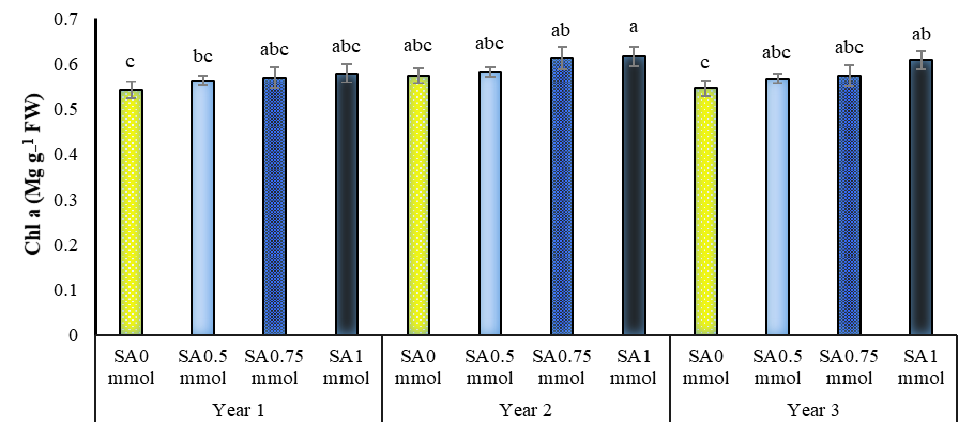
Figure 4. Dual interaction of experimental years (2016 – 2017, 2017 – 2018, and 2018 – 2019) and salicylic acid application concentrations (SA0 = non-application, SA0.5 = 0.5 mmol, SA0.75 = 0.75 mmol, and SA1 = 1 mmol) on chlorophyll a in A. hirtifolium . Columns designated by the same letter are not